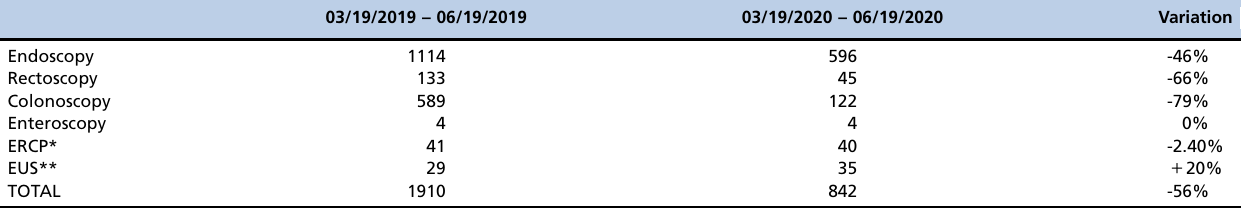
Table 2a - Digestive endoscopic procedures performed and variations between the two time periods.